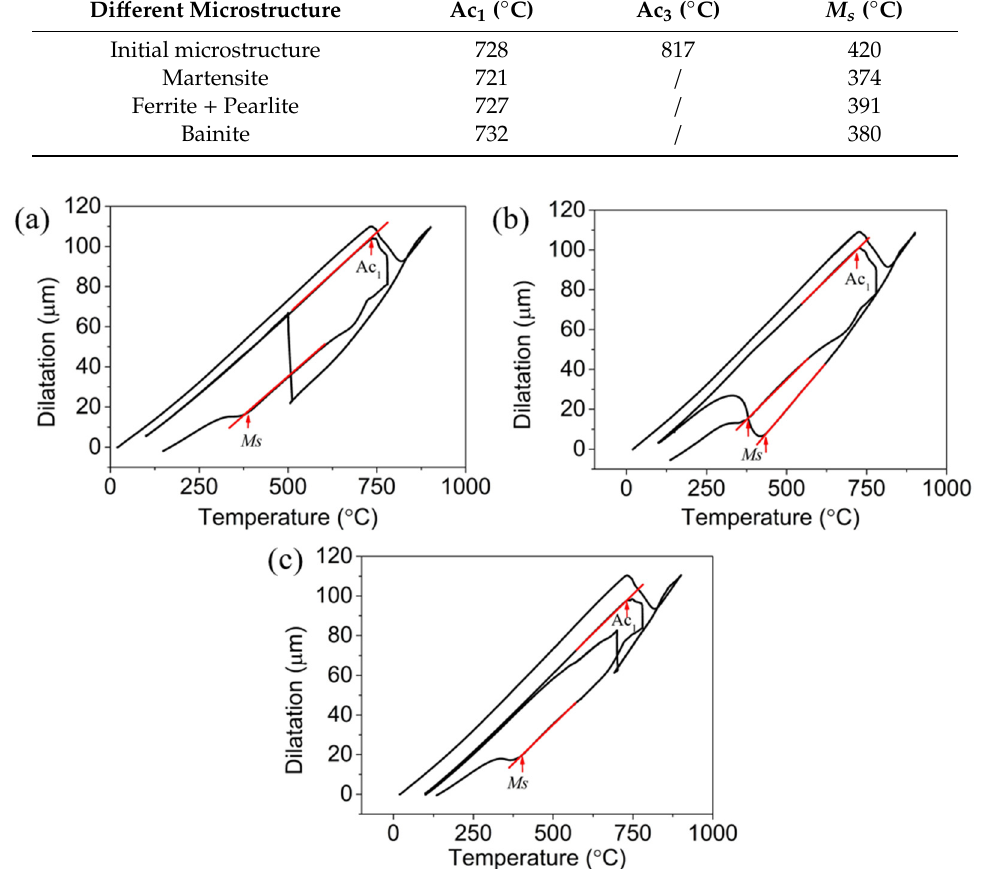
Figure 4. Dilatation temperature curves of the present steel subjected to different thermal processing routes, as shown in Figure 1, demonstrating the formation of ( a ) bainite, ( b ) martensite, and ( c ) ferrite + pearlite and their effects on the austenite reverse transformation.